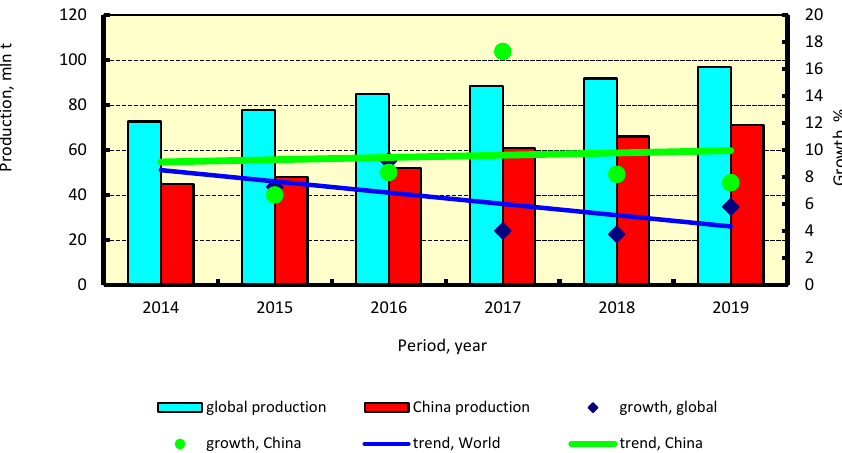
Figure 1. Global and China methanol production.